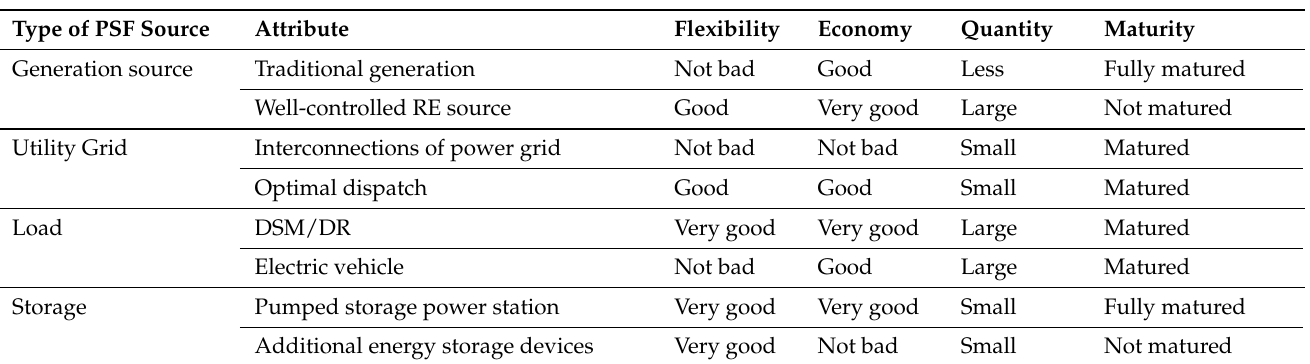
Table 6. Characters of PSF